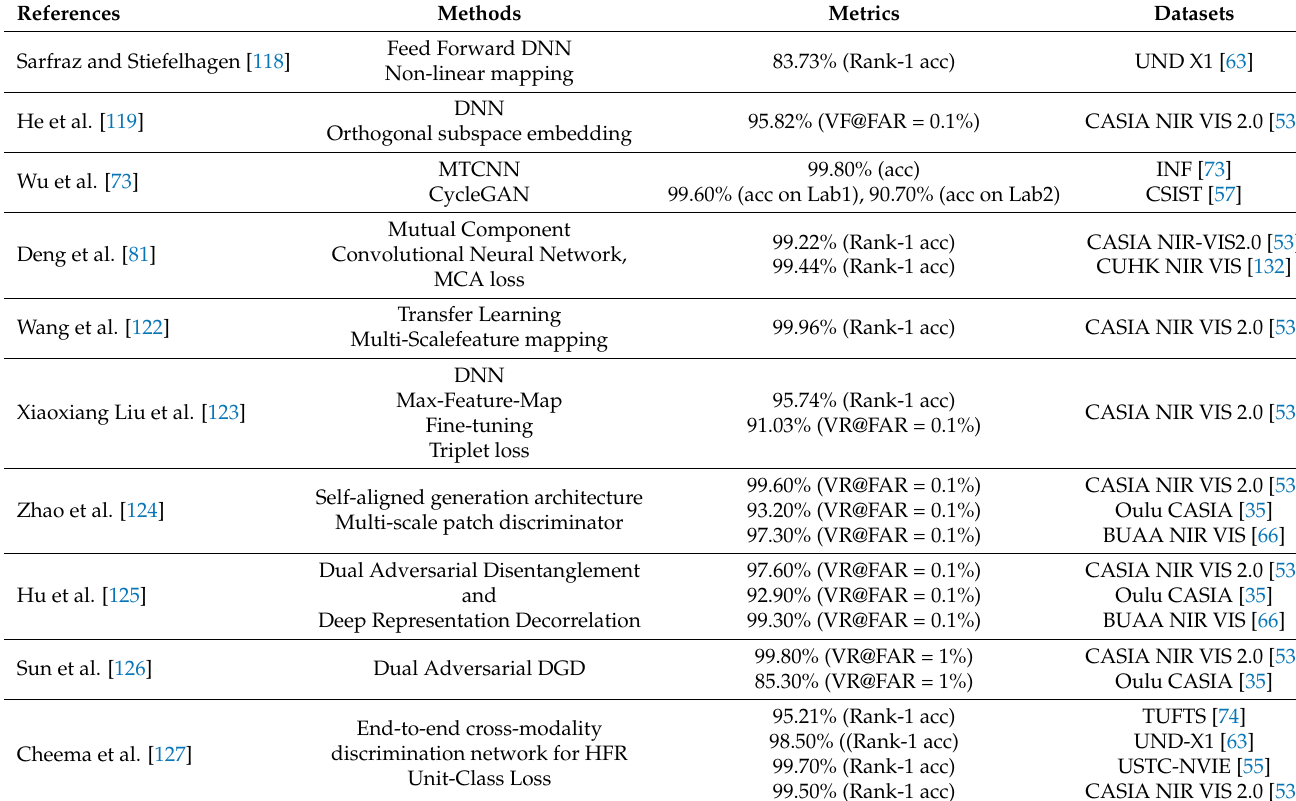
Table 4. Comparison of NIR VIS alignement approaches results.